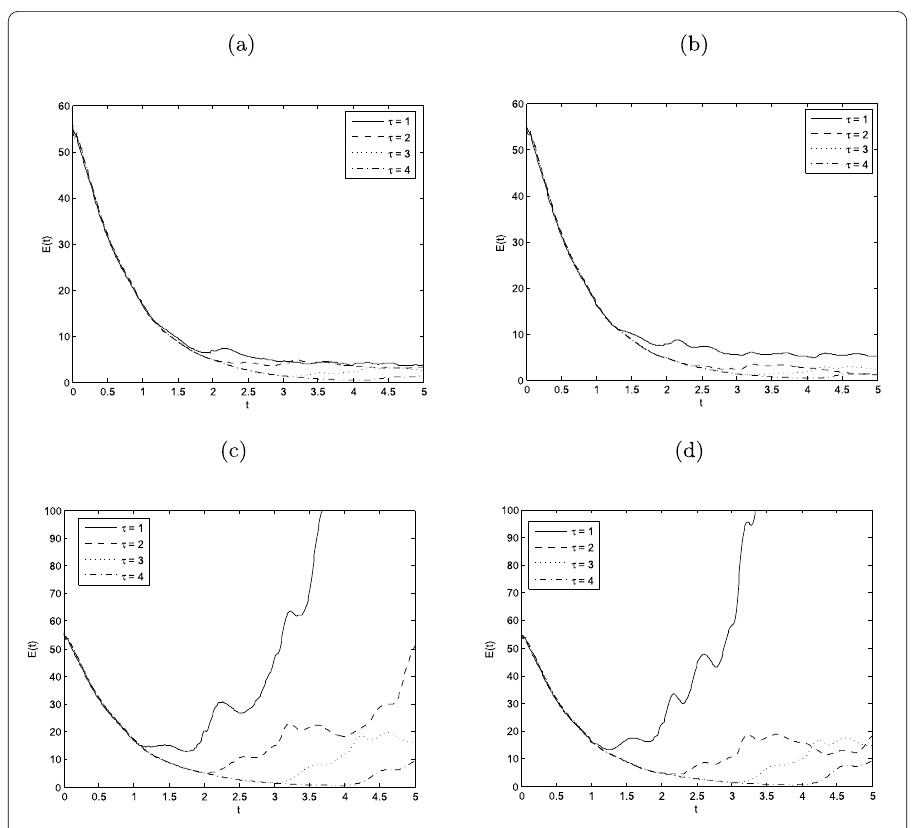
Figure 16 The energy E ( t ) of the wave system (1.16)-(1.20) with a ( x ) = e ( x 1 x 2) and for different delays when: a) k = 0.4; b) k = –0.4; c) k = 1; d) k =